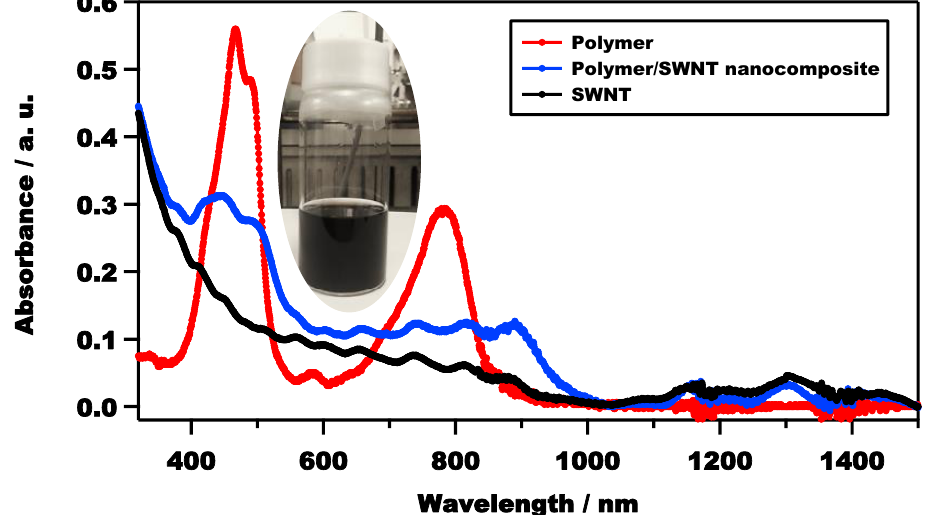
Figure 4. UV-visible spectra of porphyrin polymer ( 1f ), SWNT, and polymer/SWNT nanocomposite measured in THF. The spectra show an obvious chemical shift in both the Soret band and Q-band compared with the polymer ( 1f ) due to non-covalent interaction. The inset displays the polymer/SWNT nanocomposite sample dispersed in THF.